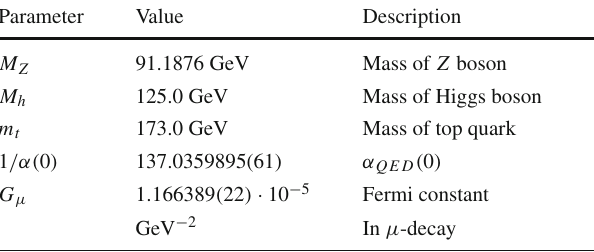
Table 10 Dizet initialization parameters: masses and